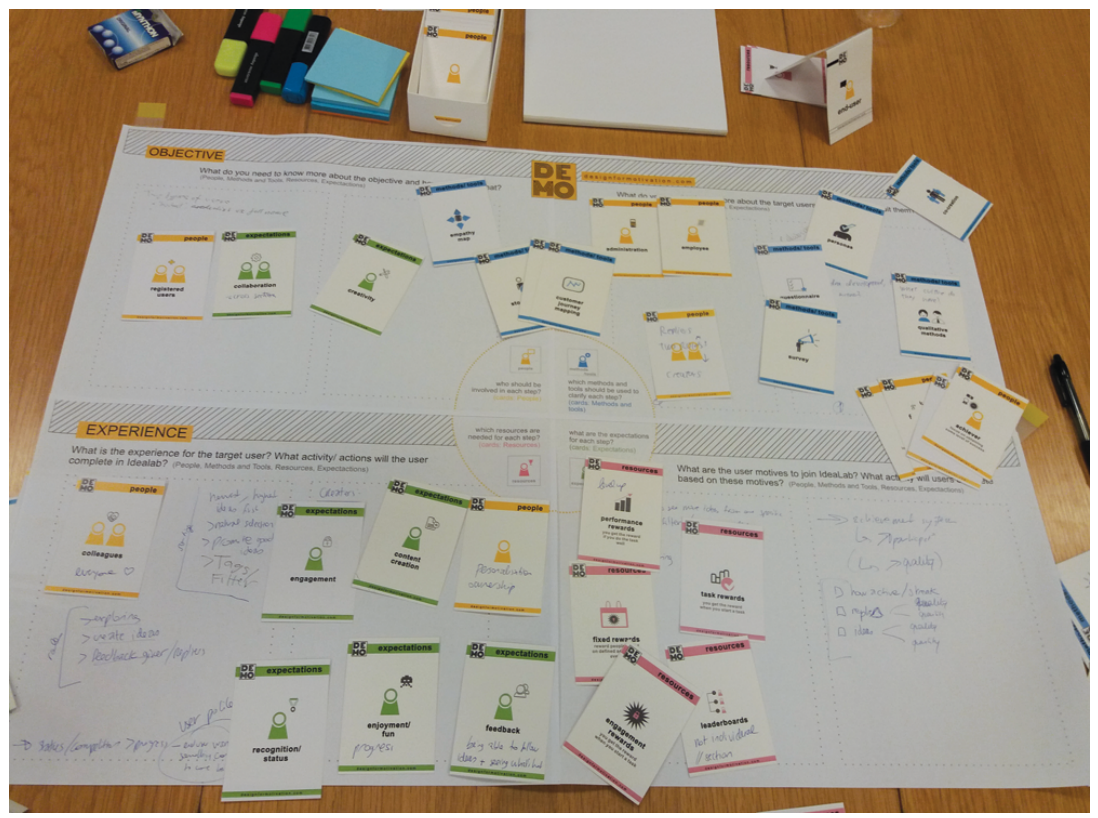
Figure 4. The design cards and the board of the DEMO tool after a workshop